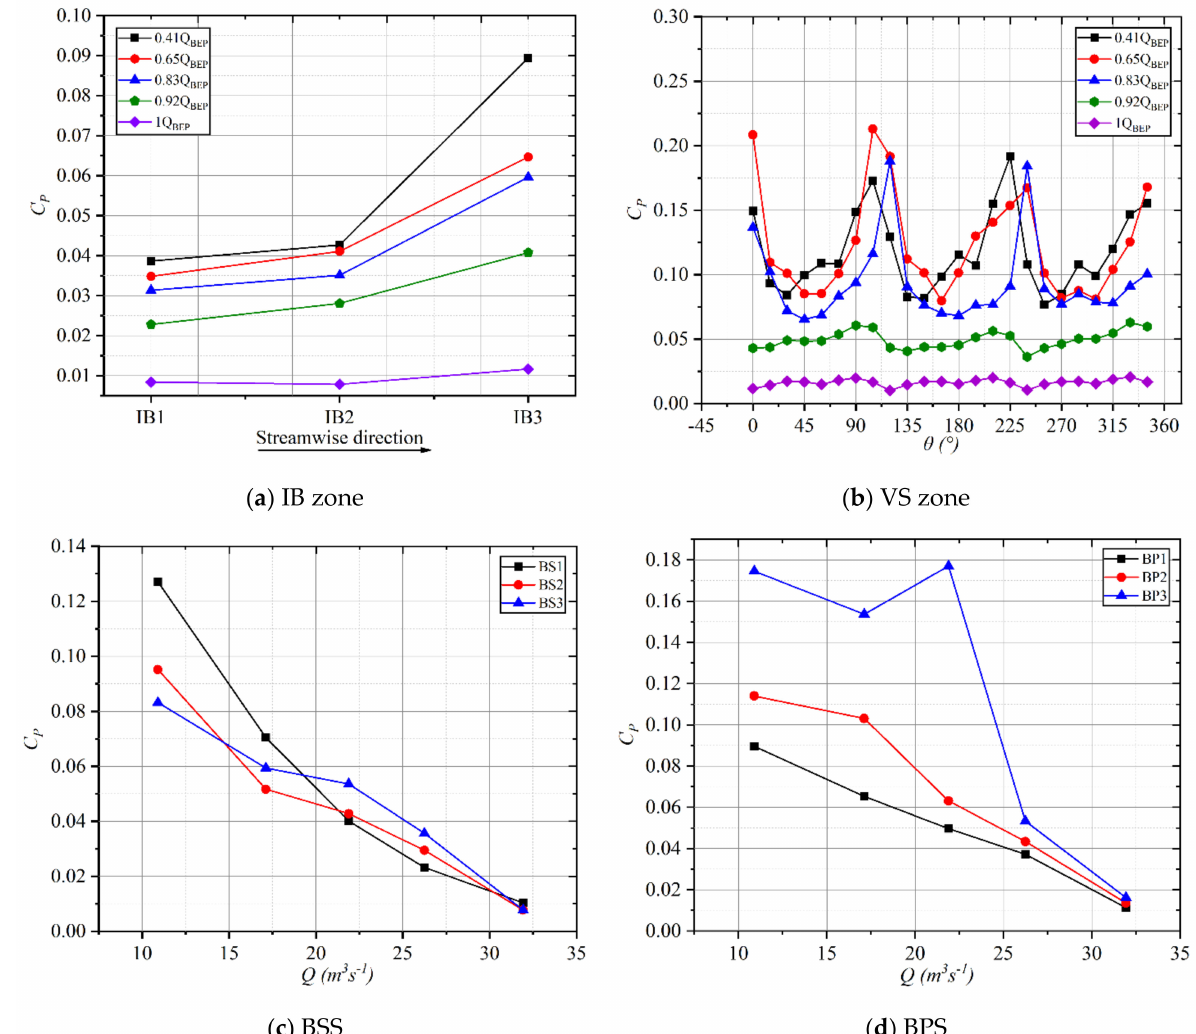
Figure 18. Pressure pulsation amplitude variation within the runner and vaneless space flow